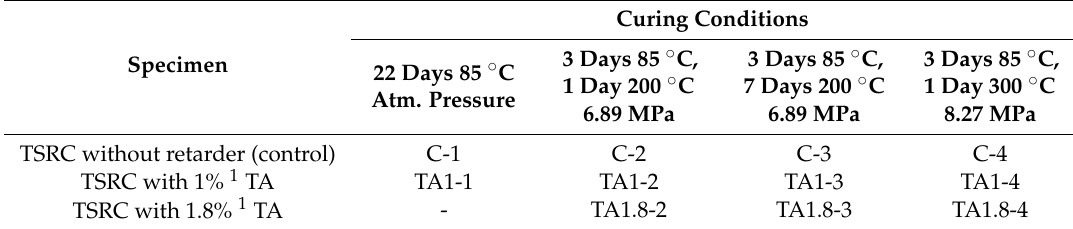
Table 2. Specimens’ curing conditions.